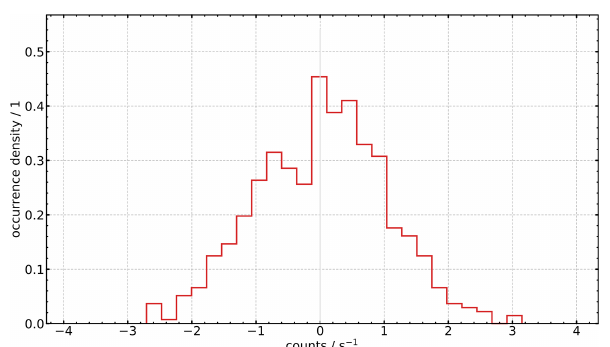
Figure 9. Relative deviation between measured count rate of the ref- erence monitor and calculated count rate from the emanation source 2018–1121 at 30min temporal resolution shown as a histogram. The natural behaviour proves the correctness of the model, while the narrow width stresses the good statistics (low noise) of the de- tector even at these low activity concentrations (below 20Bqm − 3 ).